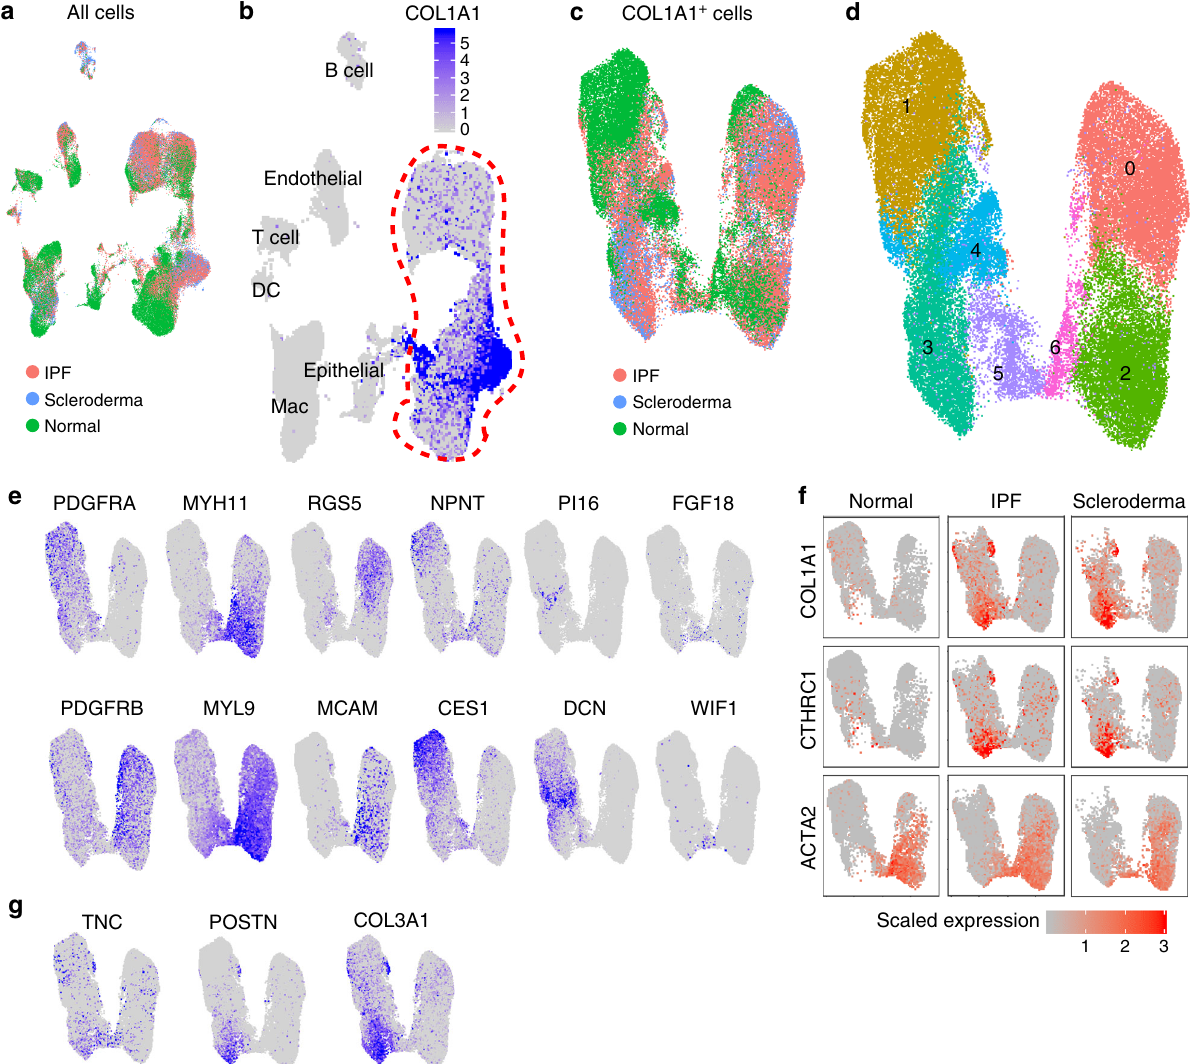
Fig. 5 scRNA-seq identi fi es CTHRC1 + pathologic fi broblasts in human fi brotic lungs. a UMAP plot of all cells acquired by scRNA-seq of human samples. Cells were obtained from three normal lungs (green), three IPF lungs (red), and two scleroderma lungs (blue). b COL1A1 expression on UMAP plot. See Supplementary Fig. 5a for lineage identi fi cation. DC, dendritic cells; Mac, macrophage. c UMAP plot of COL1A1 + cells. d Unsupervised clustering identi fi ed 7 clusters. e Expression levels of representative genes are shown on UMAP plots. f Expression of COL1A1 , CTHRC1 , and ACTA2 are shown on UMAP plots. Cells from normal, IPF, and scleroderma lungs are shown separately in each column. g Expression levels of selected ECM genes on UMAP